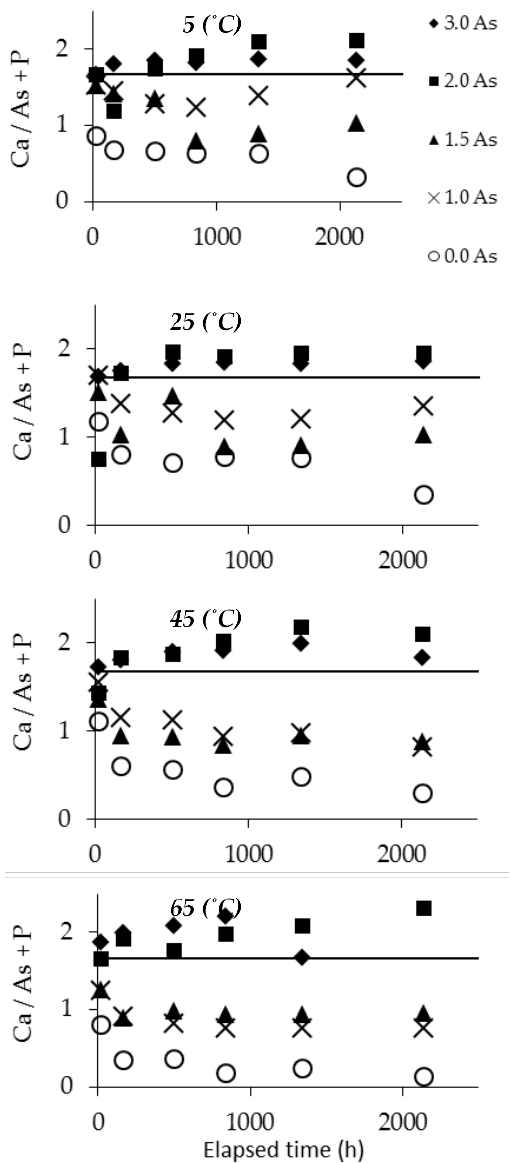
Figure 9. The variability in the congruency of dissolution during the dissolution experiment based on molar proportion of ions in solution. From top to bottom: 5, 25, 45, and 65 °C. The horizontal lines correspond to ideal stoichiometric character of dissolution, 1.67.